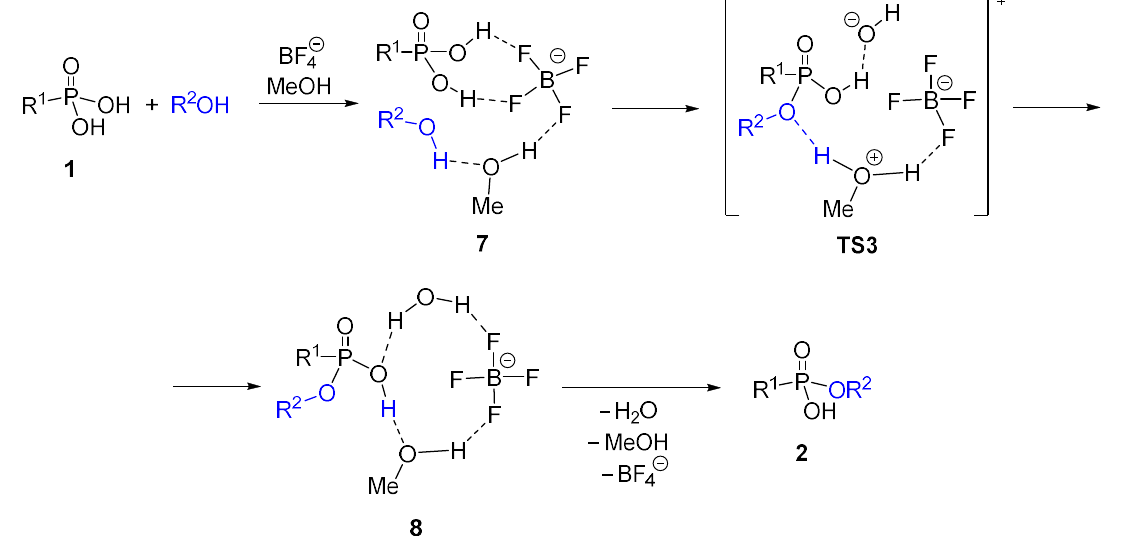
Table 6. Energetics for the [bmim][BF 4 ]-promoted esterification of alkylphosphonic acids ( 1 ) with alcohols obtained by DFT